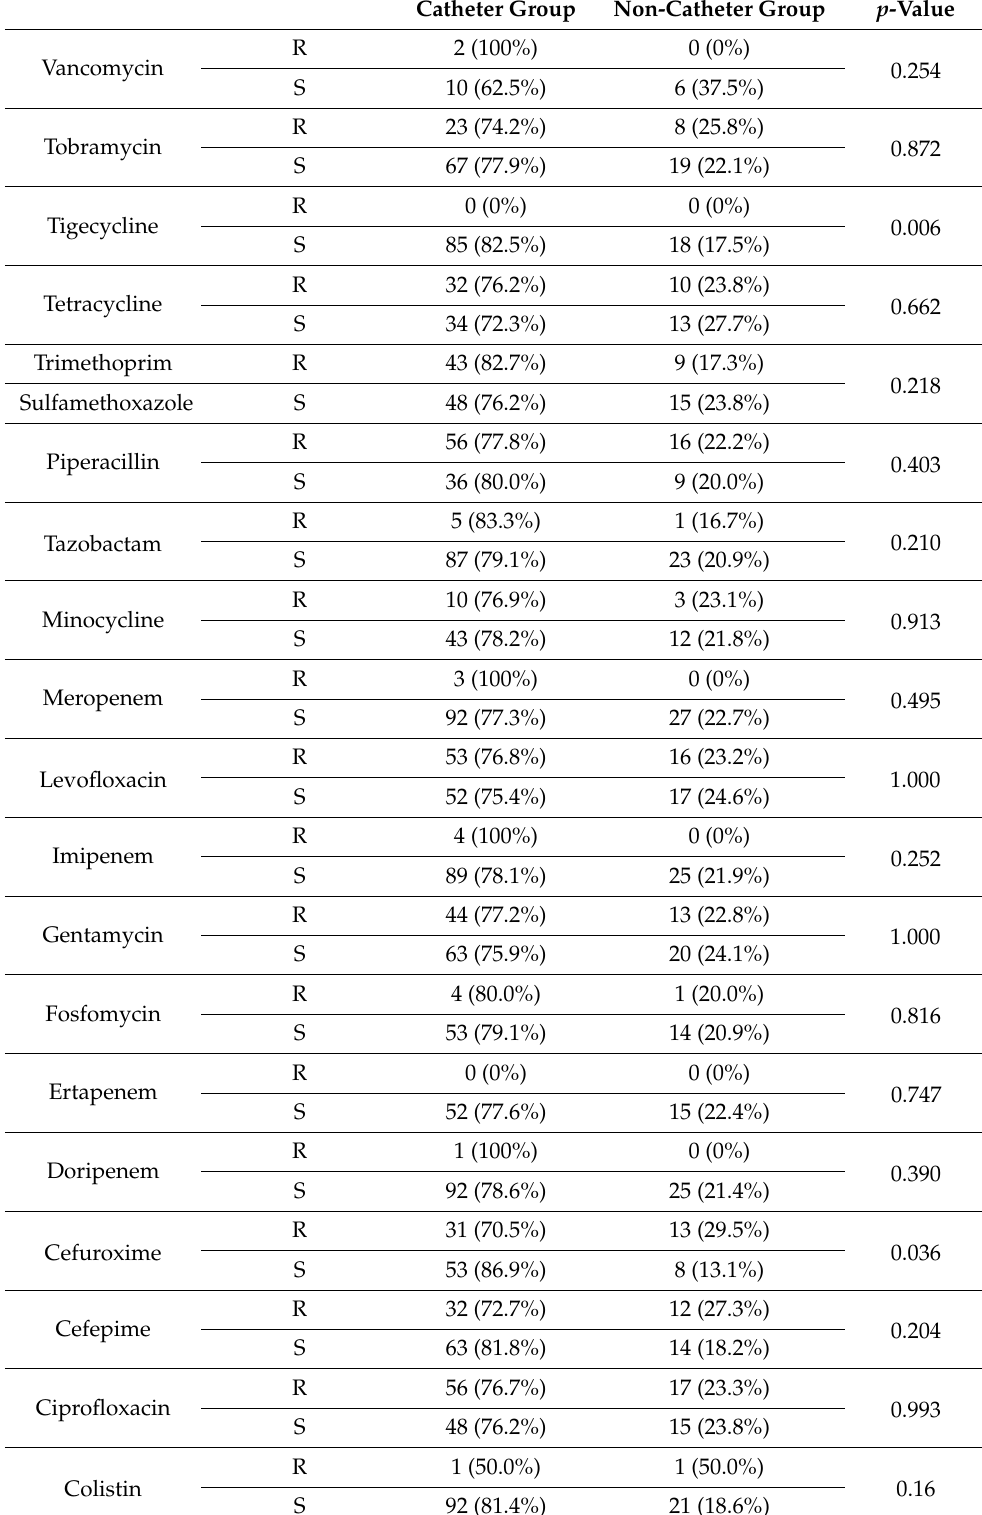
Table 6. Antibiotic sensitivity according to catheter